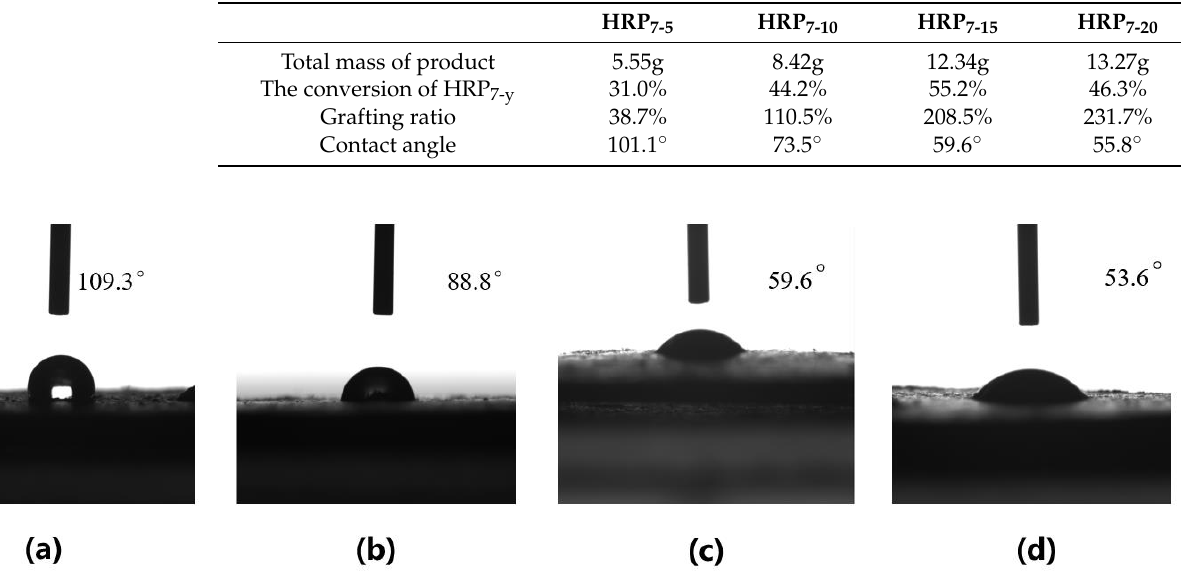
Figure 3. Contact angle of WRP ( a ), HRP 7-5 ( b ), HRP 7-10 ( c ), HRP 7-15 ( d ), and HRP 7-20 ( e ). Table 1. The grafting ratio of HRP 7-y with different amounts of AM.